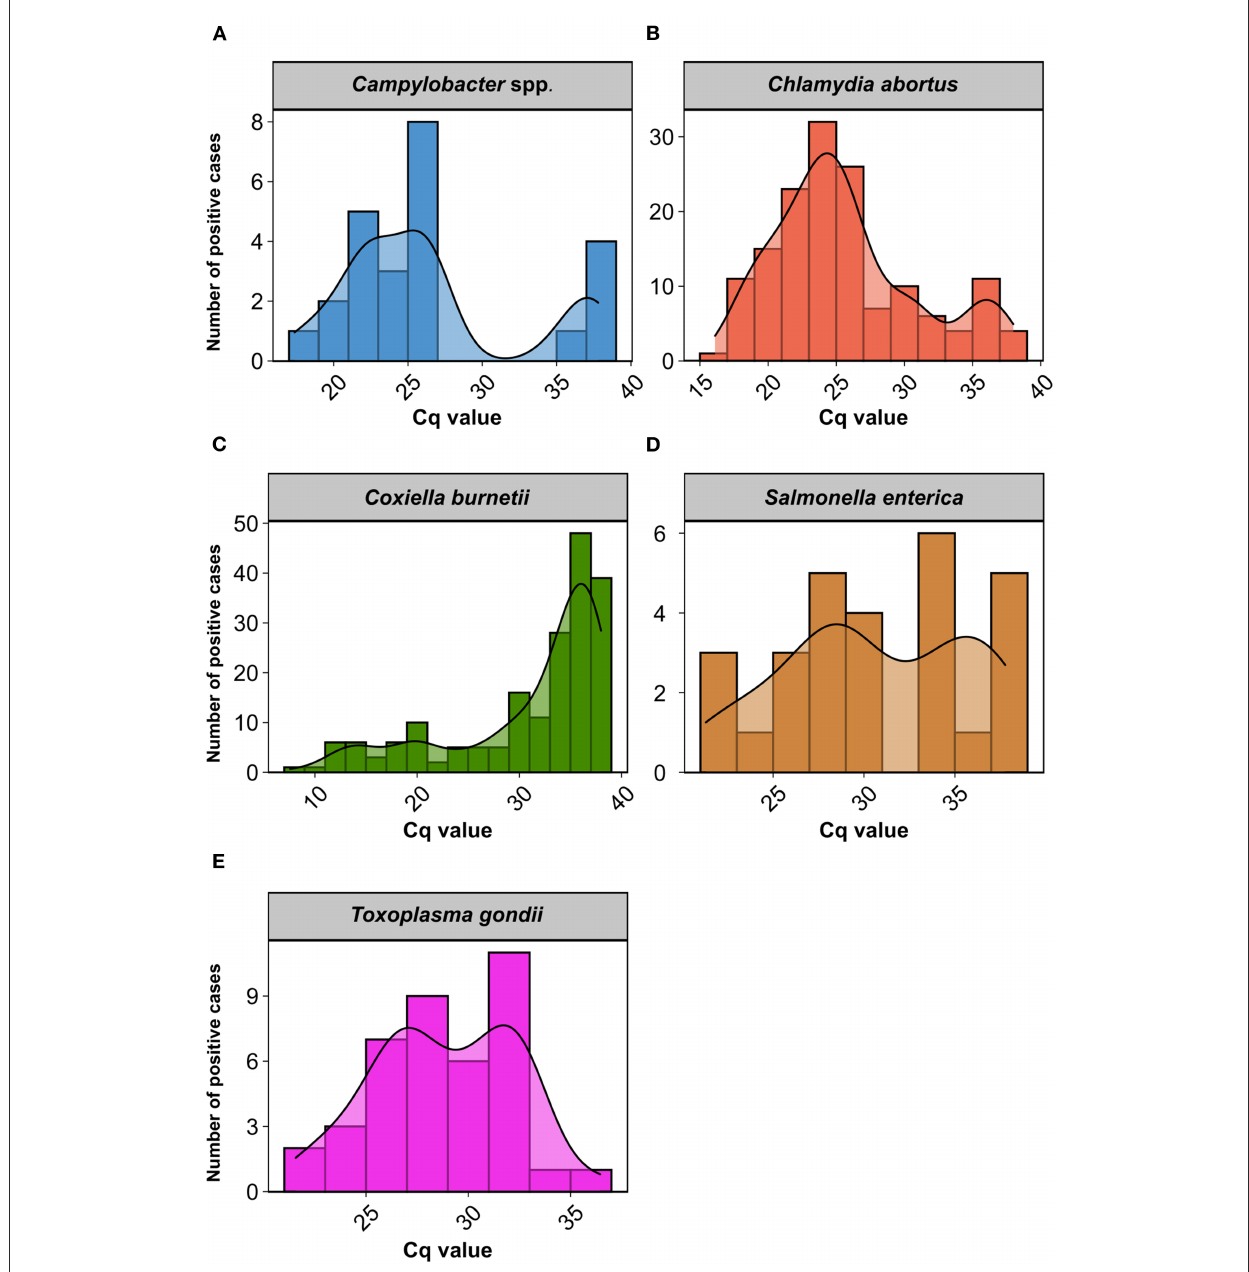
FIGURE3 Histogram and density plot representing the distribution of cycle of quantification (Cq) values in clinical cases of abortion in small ruminants positive to (A) Campylobacter spp.; (B) Chlamydia abortus ; (C) Coxiella burnetii ; (D) Salmonella enterica ; and (E) Toxoplasma gondii